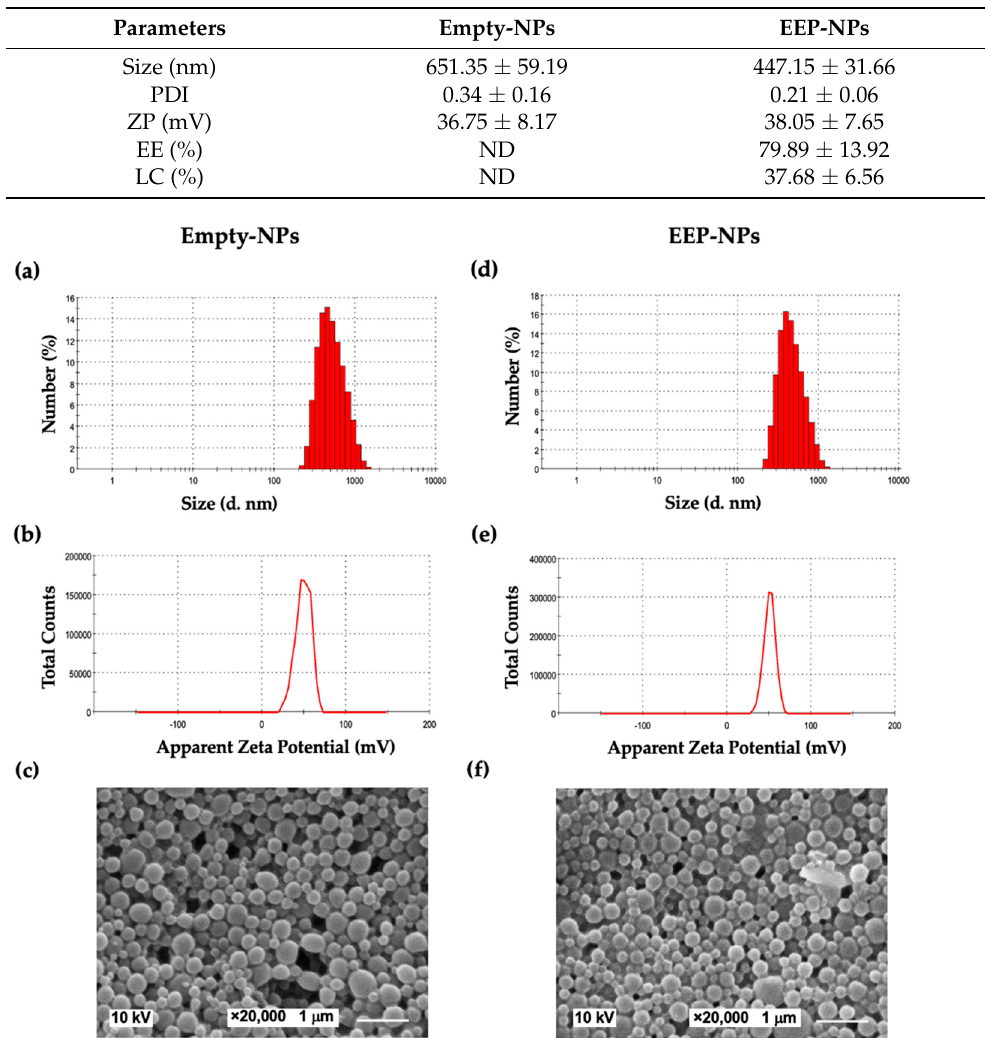
Table 1. Particle size, polydispersity index (PDI), ζ potential (ZP), and entrapment efficiency (EE) of the NPs.